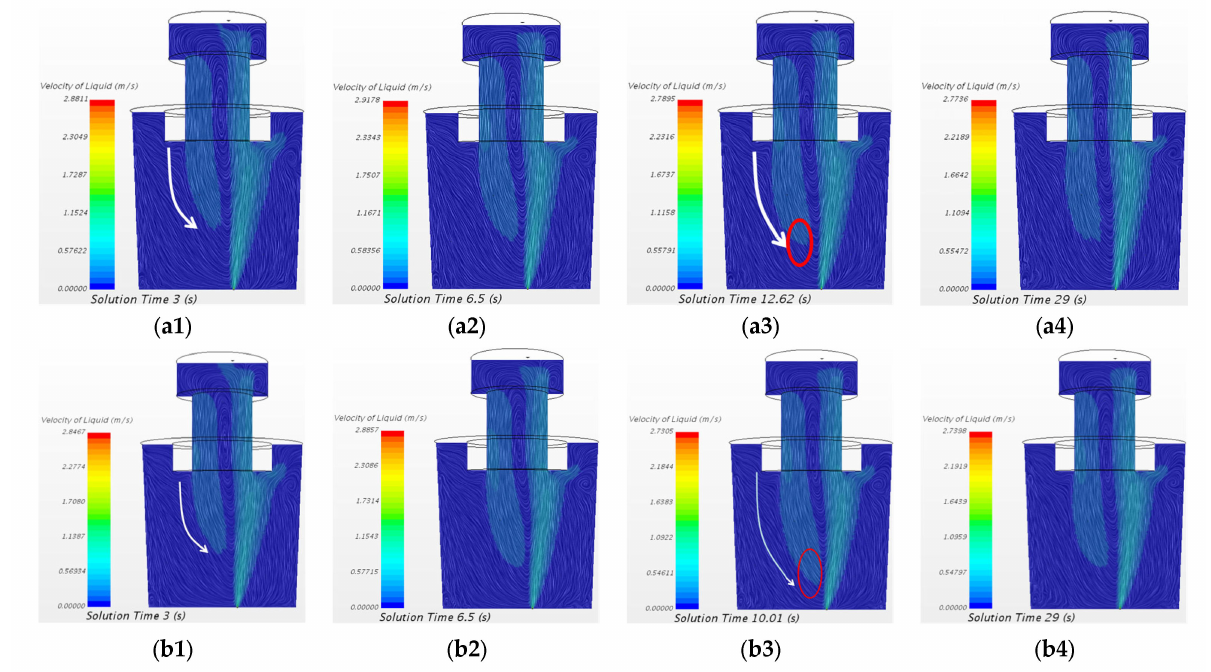
Figure 9. Comparison of flow field between the case of 20 mL KCl tracer and the case of 150 mL KCl tracer in the water model at the central longitudinal section of SSRF at different time steps.